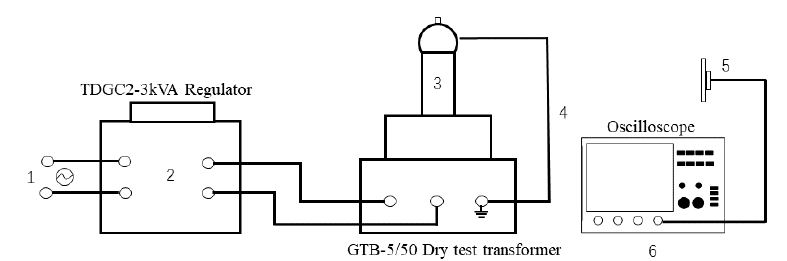
Figure 19. Schematic diagram of the probe detection partial discharge test platform.